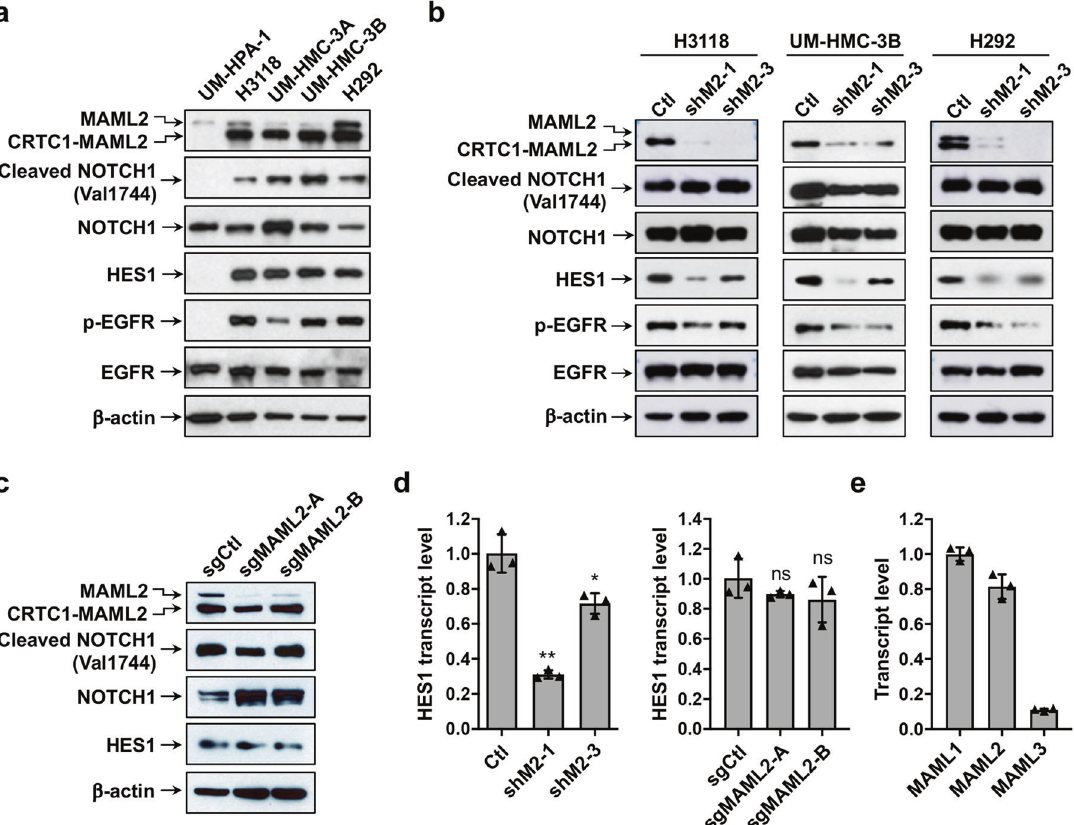
Fig. 1 NOTCH1 and EGFR signaling pathways were activated in human CRTC1-MAML2 fusion-positive MEC cells. a Western blot analysis was carried out on human CRTC1-MAML2-positive MEC cell lines (H3118, UM-HMC-3A, UM-HMC-3B, and H292) and a fusion-negative cells line (UM-HPA-1) using various antibodies as indicated. b Human MEC cells (H3118, UM-HMC-3B, and H292) were transduced with lentiviruses expressing shRNAs (shM2-1, shM2-3) that target the respective 3 ′ UTR and TAD domain of the CRTC1-MAML2 fusion and MAML2, or control shRNA (Ctl). Cells were collected at 96 h after viral infection and western blotting was performed. c Stable Cas9-expressing H3118 cells were transduced with lentiviruses expressing sgRNAs that target the exon 1 of MAML2 (sgMAML2-A, sgMAML2-B) or control (sgCtl). Cells were harvested at 96 h after viral infection and western blotting was performed. d Quantitative RT-PCR analysis of HES1 transcript levels in transduced MEC H3118 cells as described in ( b ) and ( c ) ( n = 3; ns, p > 0.05; * p < 0.05; ** p < 0.01). e Quantitative RT-PCR analysis of the transcript levels of three MAML co-activator family gene members, MAML1 , MAML2 , and MAML3 in human MEC H3118 cells Signal Transduction and Targeted Therapy (2021)